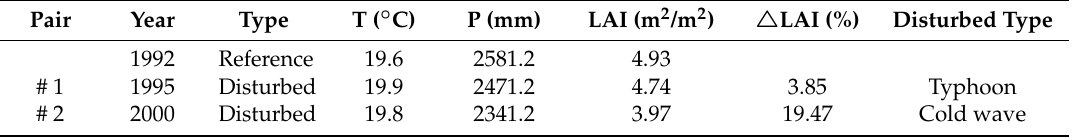
Table 1. Selected pairs by paired-year approach. LAI: Leaf area index.